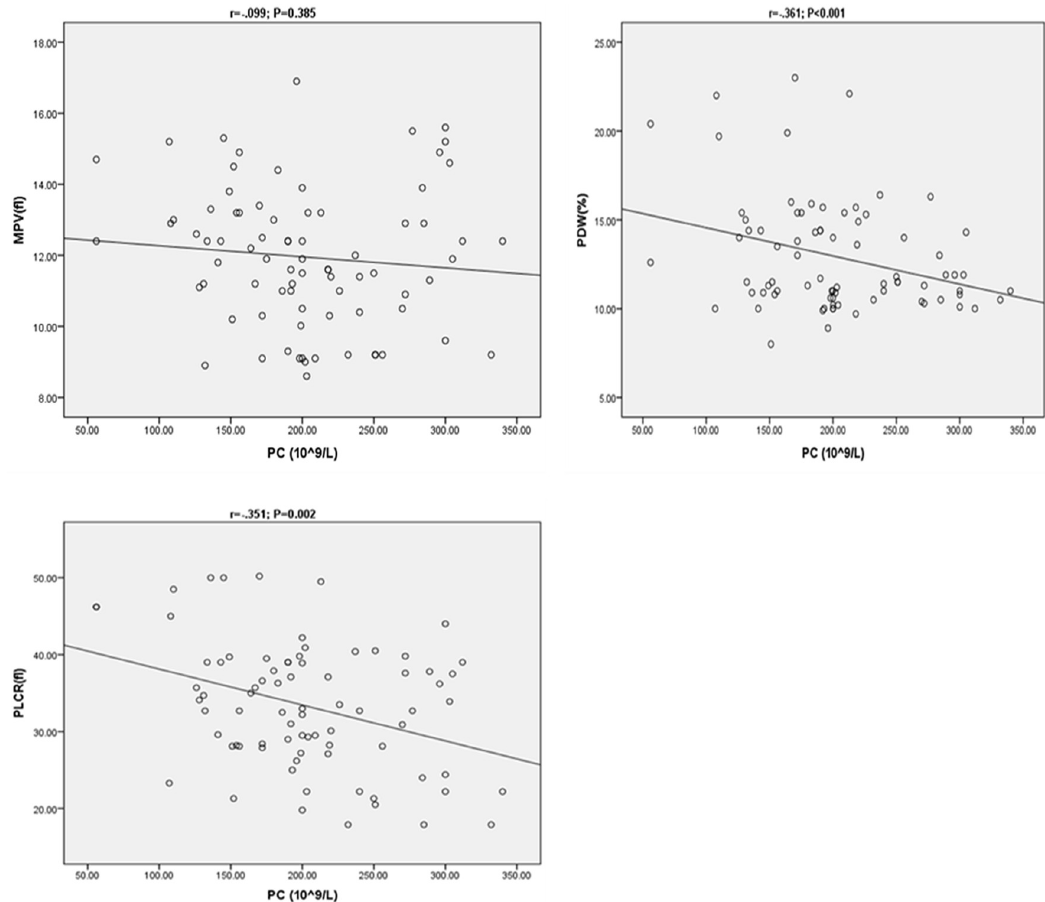
Fig 1. Correlation between PC and MPV, PDW, PLCR in women with PE (where; r = correlation coefficient). PC-Platelet Count; MPV-Mean Platelet Volume; PDW-Platelet Distribution Width; PLCR-platelet large cell ratio.